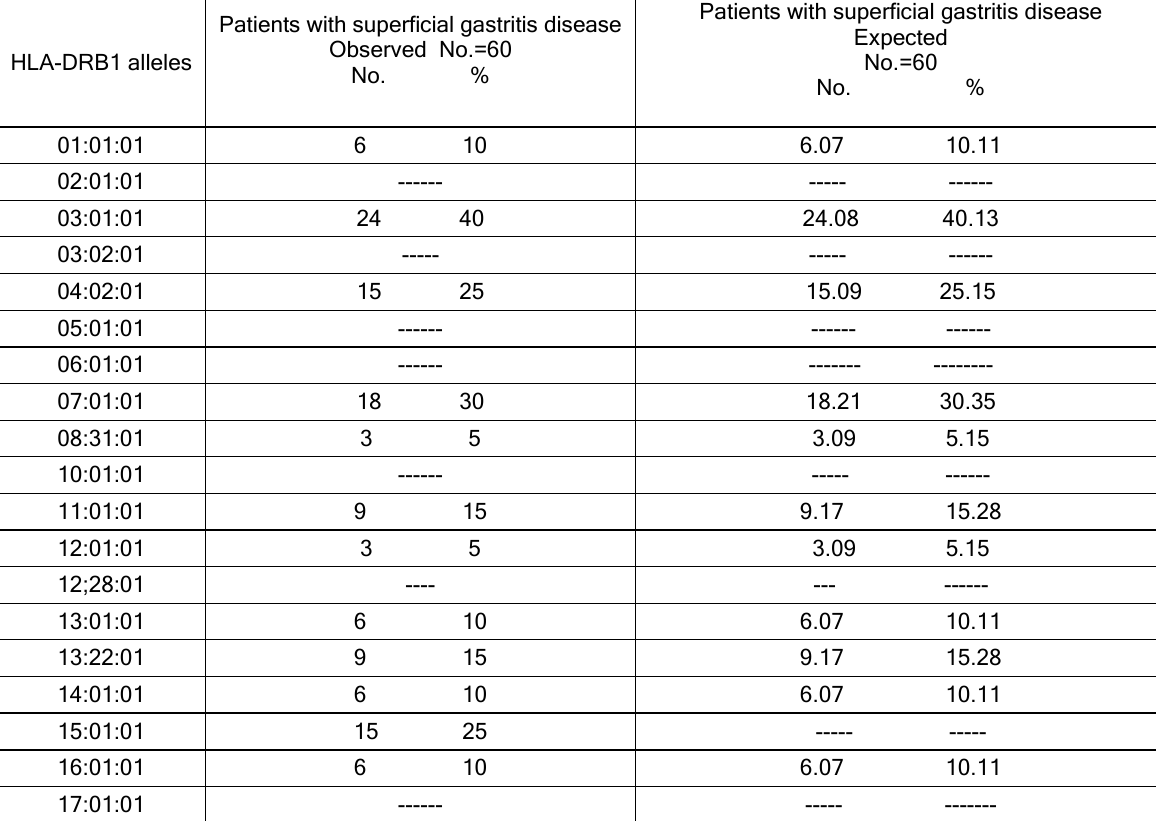
Table-2- Observed and expected numbers and percentages of HLA-DRB1 alleles in patients with superficial gastritis disease.